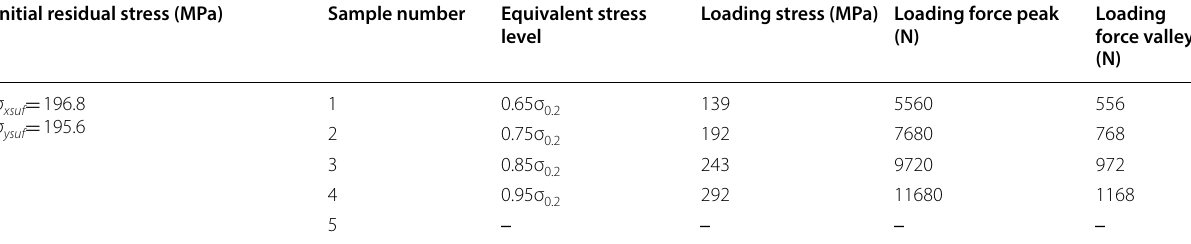
Table 6 Cyclic loading stress parameters Initial residual stress (MPa)